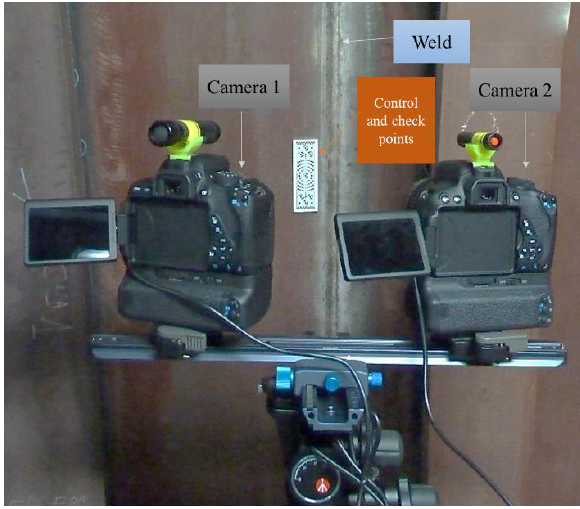
Figure 4. Stereoscopic photogrammetric arm composed by two reflex cameras (Canon EOS 700D) with two macro-lens (EF-S 60 mm).